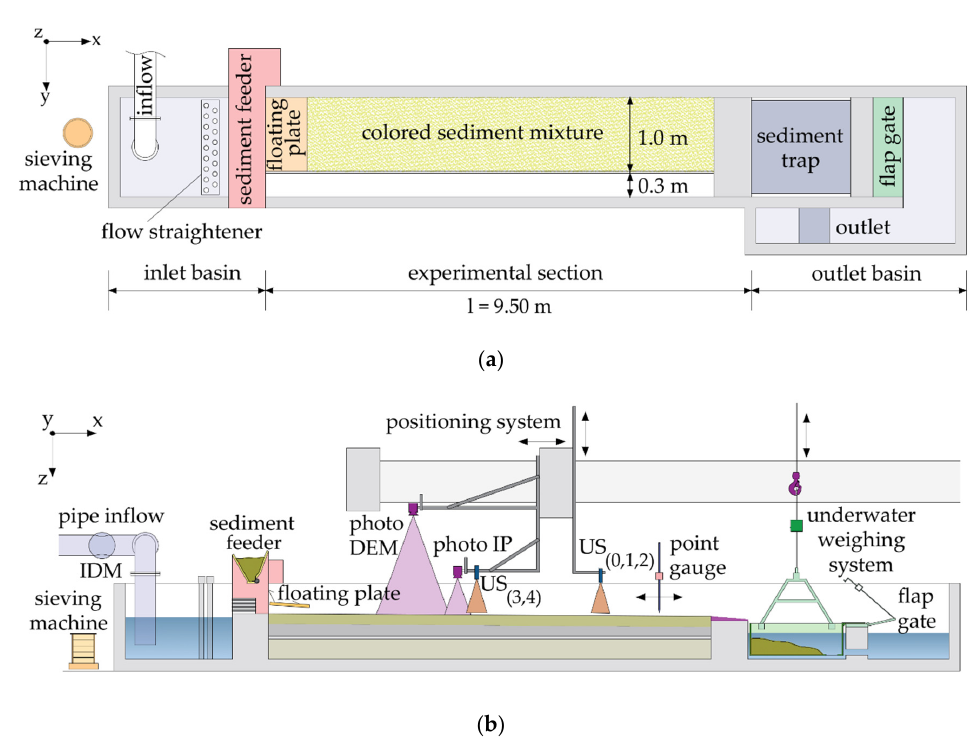
Figure 3. Experimental setup, ( a ) plan view; ( b ) longitudinal section of the straight flume. DEM = digital elevation model, IP = image processing, US = ultrasonic probe.